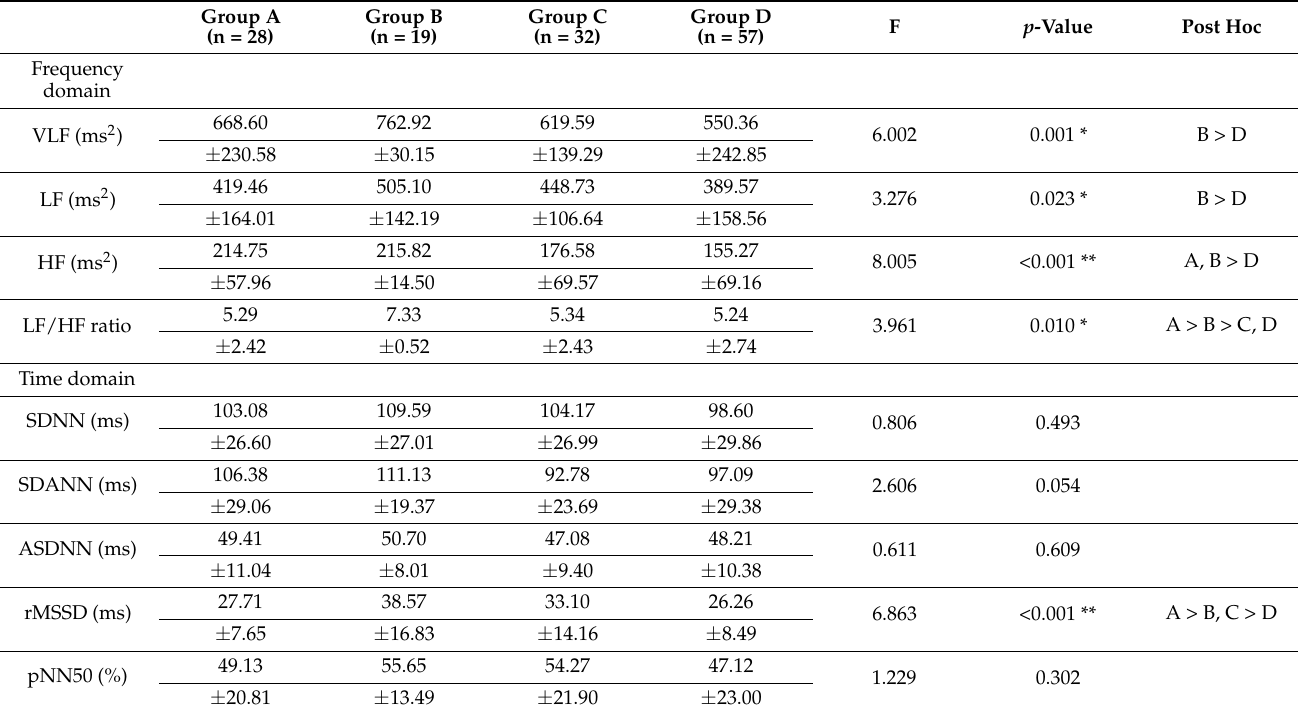
Table 3. Comparison of the HRV parameters between subgroups classified by depression